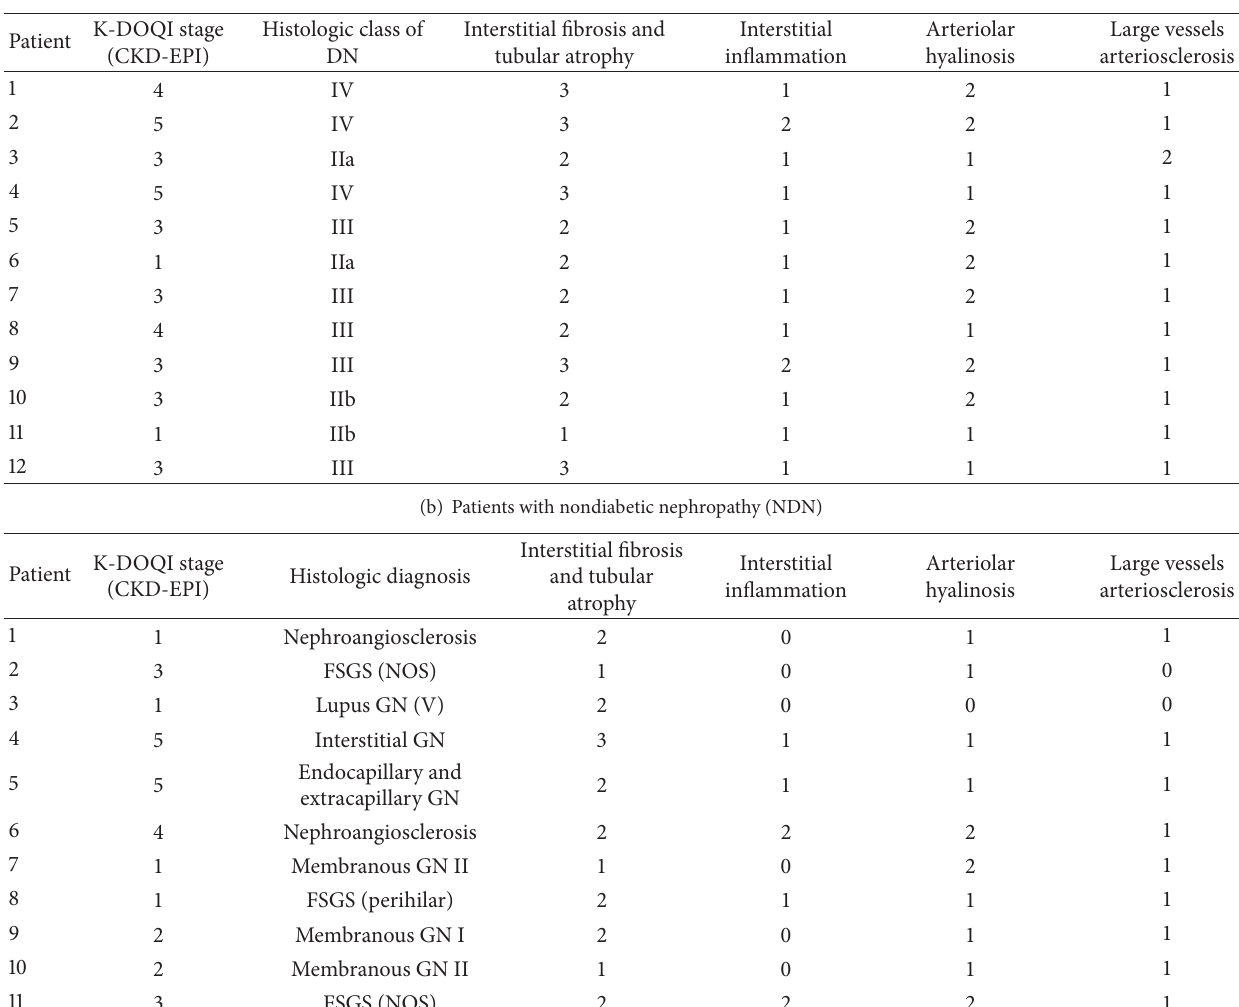
Table 2: Histologic classification of patients according to criteria proposed by Tervaert et al. [7]. (a) Patients with diabetic nephropathy (DN) K-DOQI stage Patient (CKD-EPI)